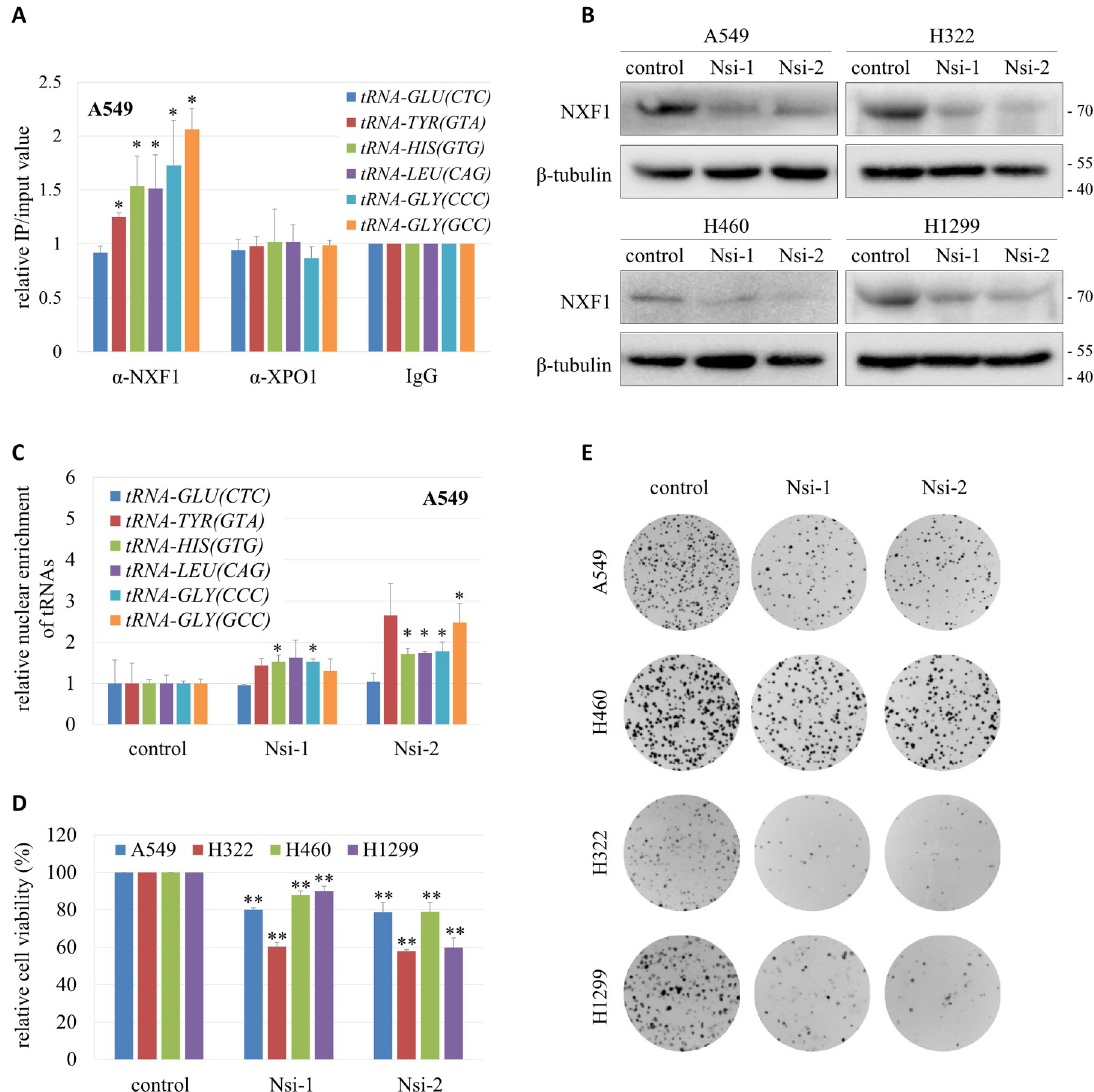
Fig 5. A role for NXF1 in tRNA nuclear export. (A) Interaction between NXF1 and tRNAs. RIP assay was performed with α -NXF1 or α -XPO1 on A549 cell lysates. RIP with IgG served as control. RT-qPCR was performed to measure the amount of tRNA Glu(CTC) , tRNA Tyr(GTA) , tRNA His(GTG) , tRNA Leu(CAG) , tRNA Gly(CCC) and tRNA Gly(GCC) in the precipitates. Data (mean ± SD, n = 3) were analyzed by Student’s t -test in paired comparison; � P < 0.05. (B) Western blot of NXF1 in A549, H322, H460 and H1299 cells transfected with NXF1-specific siRNAs (Nsi-1 and Nsi-2) or a control siRNA. (C) Nuclear enrichment of tRNAs in A549 cells (control) and A549 cells with NXF1 knockdown (Nsi-1 and Nsi-2). Relative nuclear enrichment of each tRNA tested was determined by its nuclear / total expression normalized to the same ratio of the tRNA within the control, shown as mean ± SD (n = 2), and analyzed by Student’s t -test; � P < 0.05. (D) Cell viability measured by MTS assay. Data (mean ± SD, n = 3) were analyzed by paired Student’s t -test; �� P < 0.01. (E) Cell proliferation capacity evaluated by colony formation